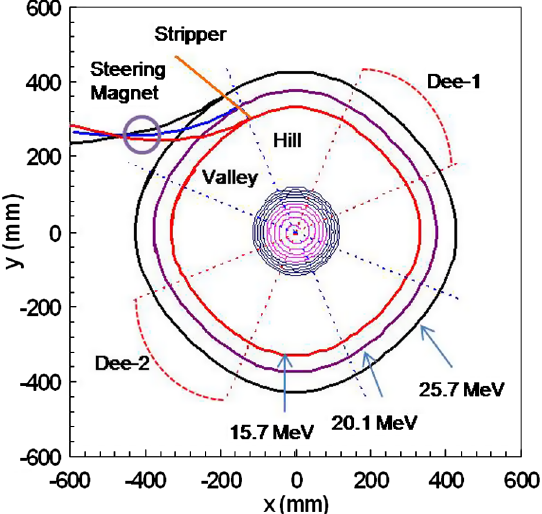
FIG. 15. Extracted orbits at 15.7, 20.1, and 25.7 MeV. For clarity, the intermediate accelerated orbits are omitted. The port selection steering magnet at the beam extraction port and the stripper movement line are also shown.